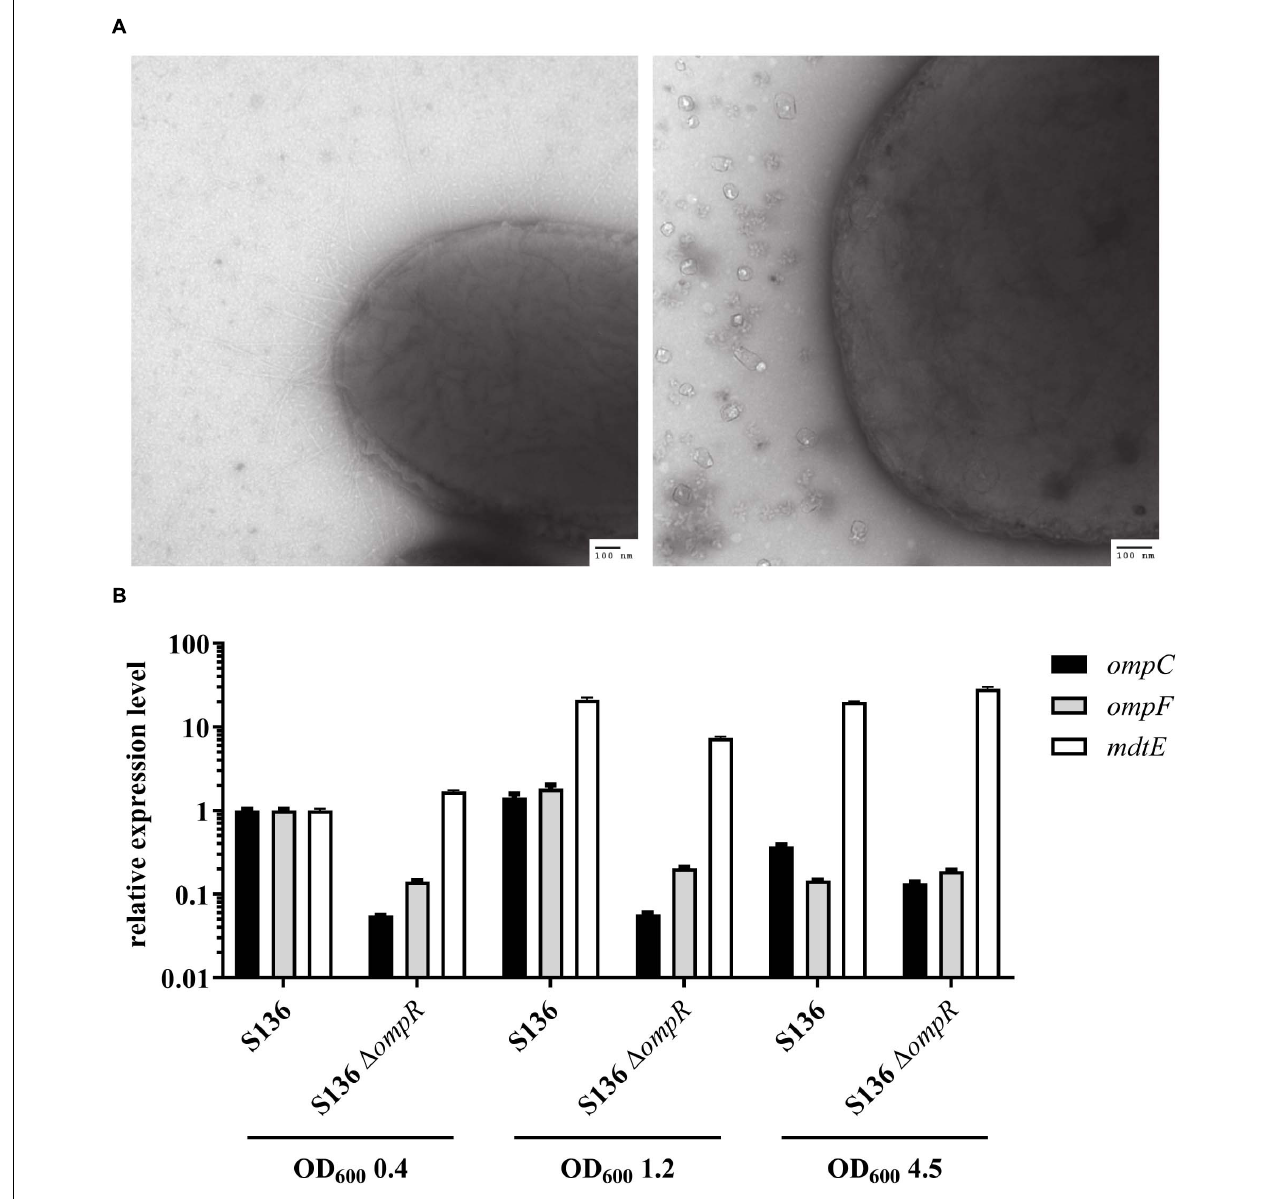
FIGURE 6 | Investigation of potential OmpR-mediated DOC tolerance mechanisms. (A) Micrographs of AIEC S136 (left) and its related (cid:49) ompR mutant (right) obtained by transmission electronic microscopy. (B) Expression levels of ompC (black bar), ompF (gray bar), and mdtE (white bar) were quantified by qRT-PCR in WT and (cid:49) ompR S136 strains at mid-log (OD 600 0.4), late-log (OD 600 1.2), and late-stationary (OD 600 4.5) growth phases. The expression levels were normalized to the S136 WT strain at mid-log phase (means ± SEM, 2 technical